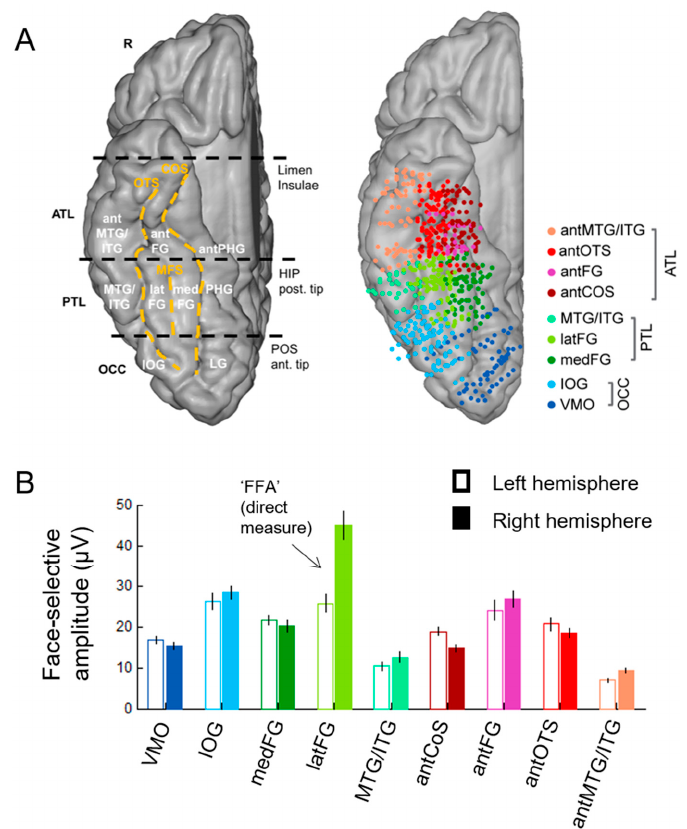
Figure 5. Individual anatomical localization of SEEG electrodes. ( A ) Left panel an example of a VOTC parcellation as used in Jonas et al. (2016) [60]. Major VOTC sulci (show as yellow dashed curves) served as mediolateral landmarks (CoS and OTS), and coronal reference planes containing given landmarks served as posteroanterior landmarks (shown as straight black dashed lines). A coronal plane, including the anterior tip of the parieto-occipital sulcus, served as the border of the occipital and temporal lobes. A coronal plane, including the posterior tip of the hippocampus, served as the border between PTL and ATL. Right panel, face-selective contacts (across 84 subjects) in the Talairach space colored according to their anatomical label in the individual anatomy. ( B ) Average amplitude of the face-selective activity in the different anatomical regions of interest as defined in each individual brain (N = 84). Note the much larger amplitude found in the lateral portion of the fusiform gyrus (latFG) in the right hemisphere. Face-selective contacts were grouped by anatomical ROIs across all participants, and the face-selective amplitude was averaged across contacts to obtain the mean response amplitude for each region separately for the left and right